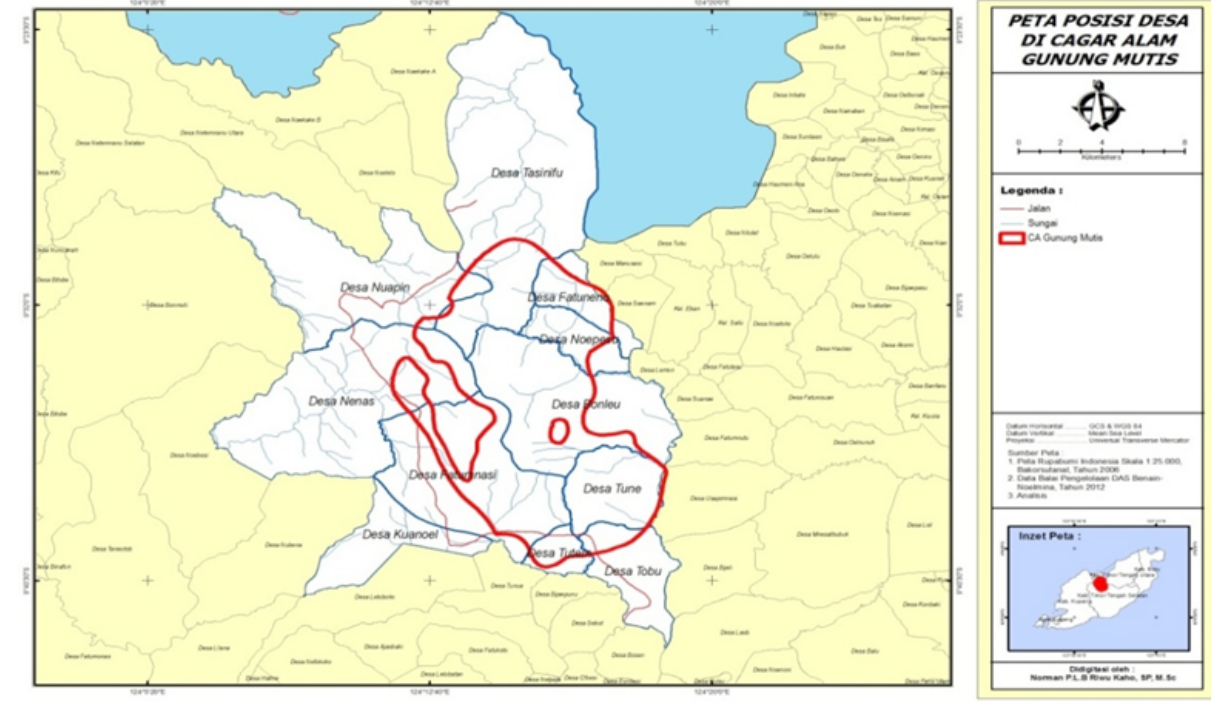
Figure 1: The administrative area of two watersheds of the Benain-Noelmina upstream